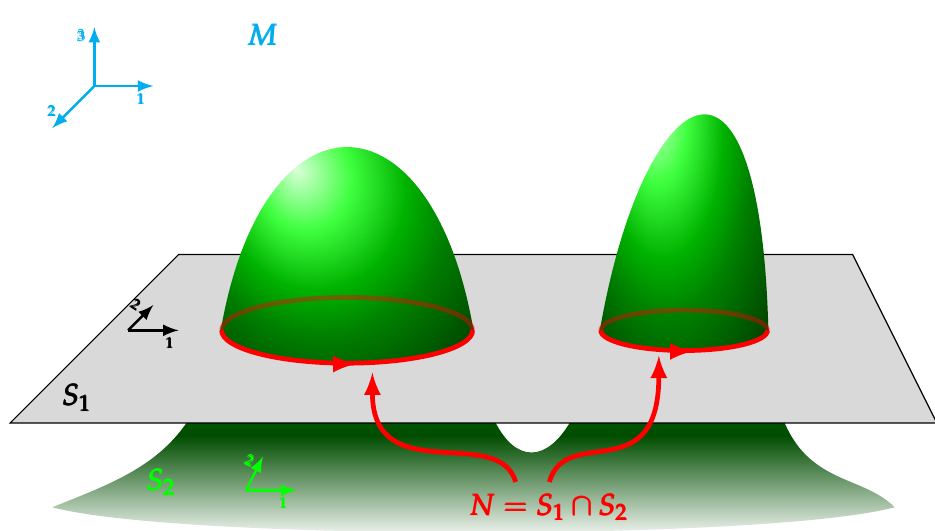
Figure 20. Intersection between two oriented surfaces S 1 and S 2 in a three-dimensional oriented manifold M .